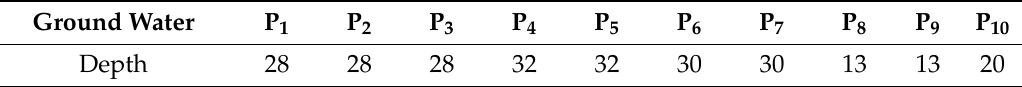
Table 1. Depth of groundwater at northern and southern plants